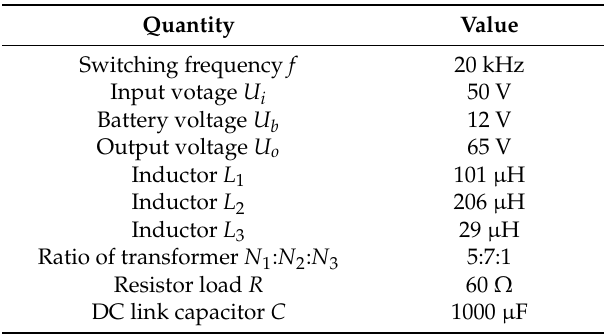
Table 2. Experimental parameters.